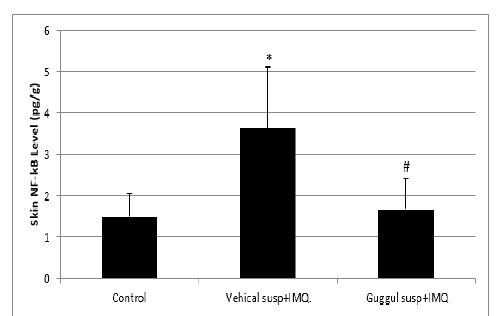
Figure 6. Effect of oral administration of guggulsterone on tissue NF-kB level in imiquimod-induced psoriasis in mice. - Each value represents mean ± standard deviation (SD). - *= Significantly different ( P <0.05) with respect to the negative control group. - # P<0.05% significant in comparison with vehicle susp+IMQ group.